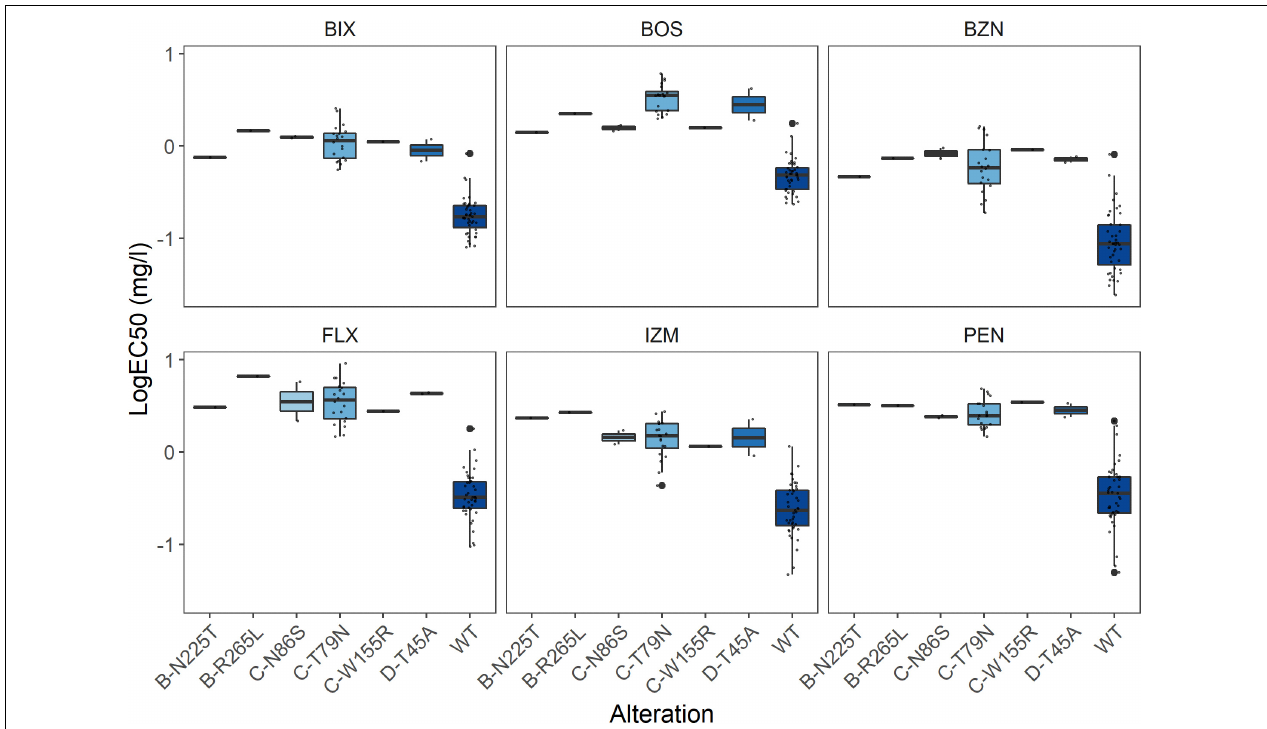
FIGURE 3 | Effect of the different Sdh subunit alterations on sensitivity towards the SDHIs bixafen (BIX), boscalid (BOS), benzovindiflupyr (BZN), fluxapyroxad (FLX), izopyrazam (IZM), and penthiopyrad (PEN). Sensitivity presented as LogEC50 (mg l − 1 ), with outliers highlighted in